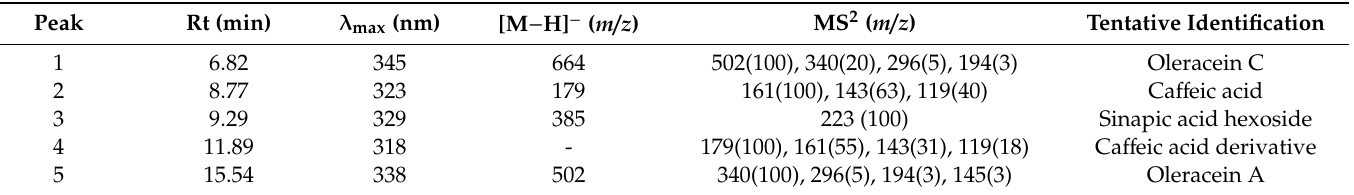
Table 5. Retention time (Rt), wavelengths of maximum absorption in the UV-VIS region ( λ max ), mass spectral data, identification and quantification of phenolic compounds and oleracein derivatives in purslane aerial plant parts (leaves and stems).